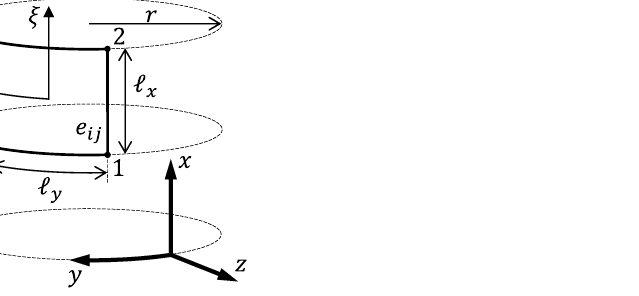
Figure 2. Single-curvature BFSC element and the global coordinate system xyz